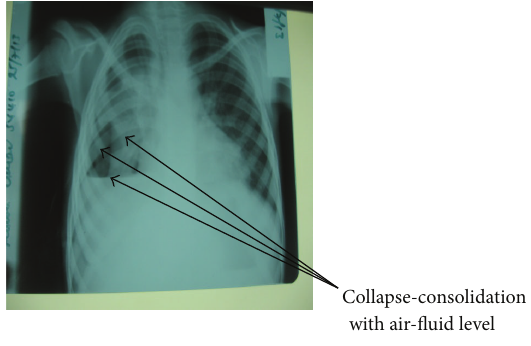
Figure 3: A chest X-ray after two-week course of